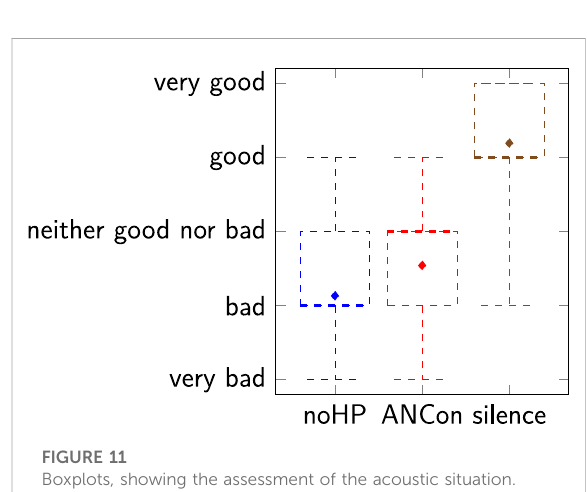
FIGURE 11 Boxplots, showing the assessment of the acoustic situation. Only exp.